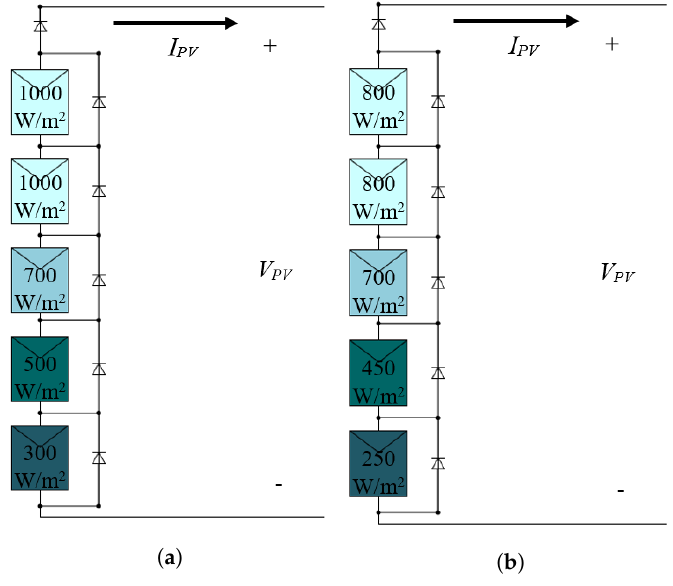
Figure 3. ( a ) Pattern a at 25 ◦ C, ( b ) pattern B at 30 ◦